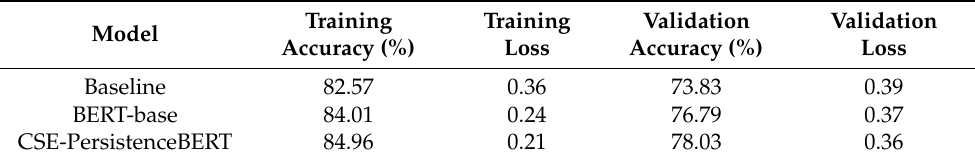
Table 5. Model benchmarks on the CSE-Persistence corpus.